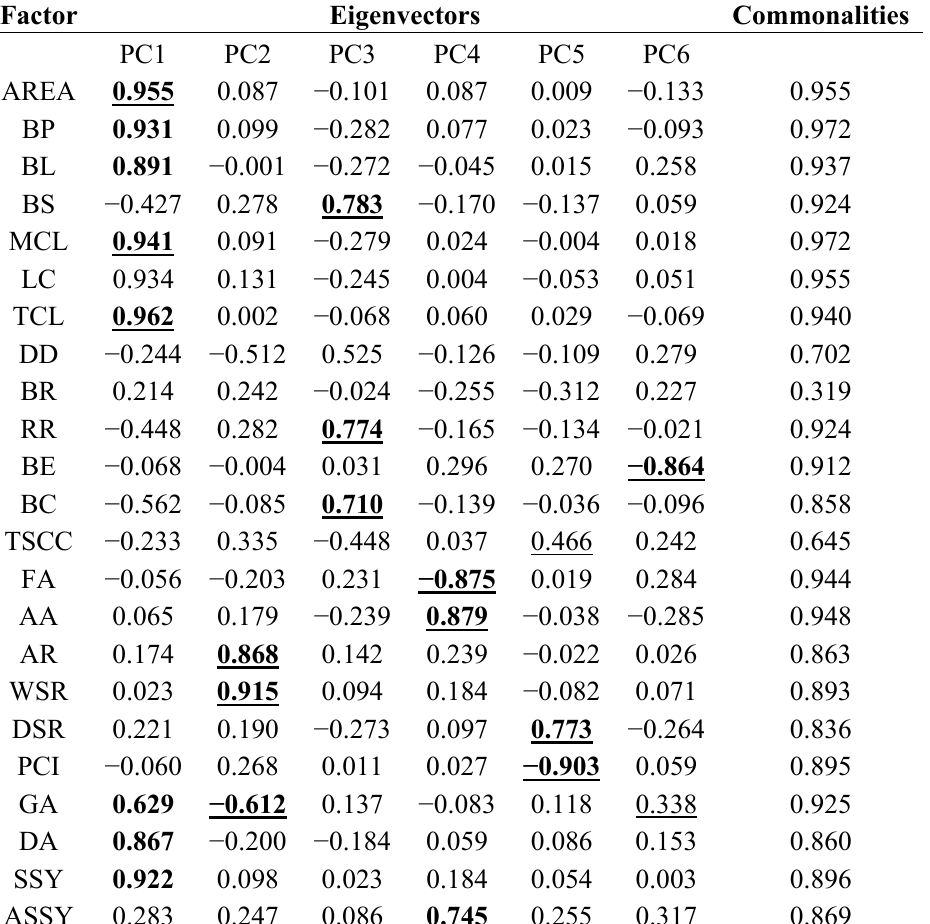
Table 6. Results of principal component analysis (Varimax rotated component